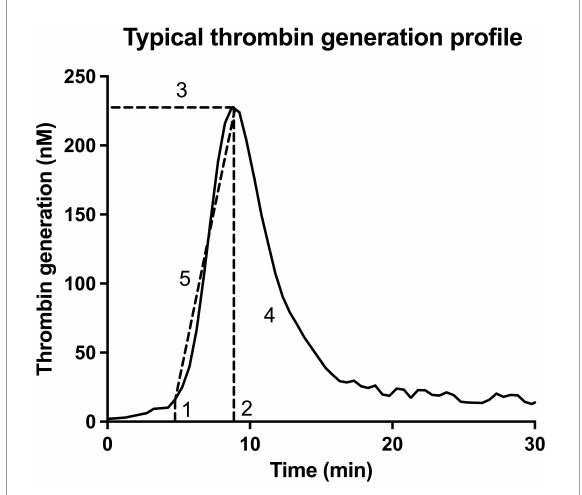
FIGURE1 Essential parameters obtained with the thrombin generation assay. This thrombin generation assay is visually represented by the first derivative of the thrombin generation signal. The important parameters describing this curve include lag time (1), which describes the time between application of the trigger and the initiation of thrombin generation; time to thrombin peak (2) when the generation of thrombin is maximal; thrombin peak height (3) evaluating maximum generated quantity of thrombin; the area under the curve (AUC, also called endogenous thrombin potential (ETP), (4) where the total amount of thrombin generation is evaluated; as well as the velocity index (5) which describes the slope of the curve during the amplification